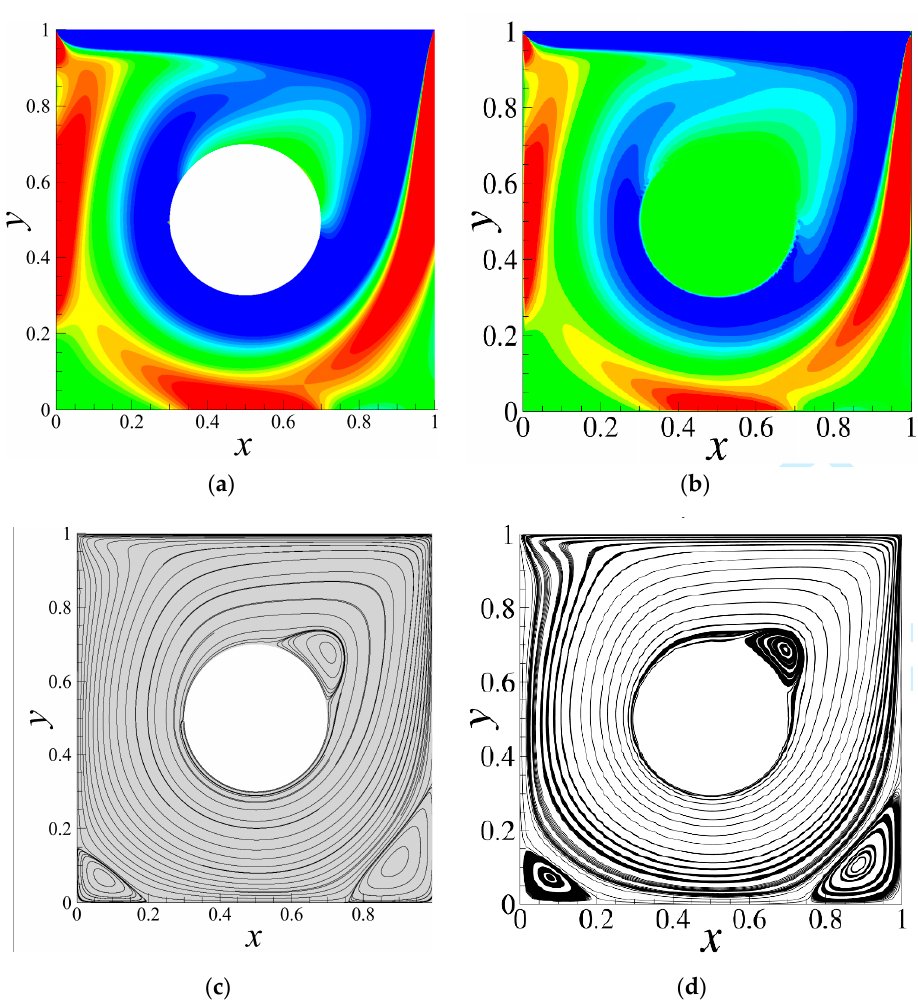
Figure 1. The lid-driven square cavity flow with an embedded circular obstacle. ( a ) Model ( b ) Meshes.